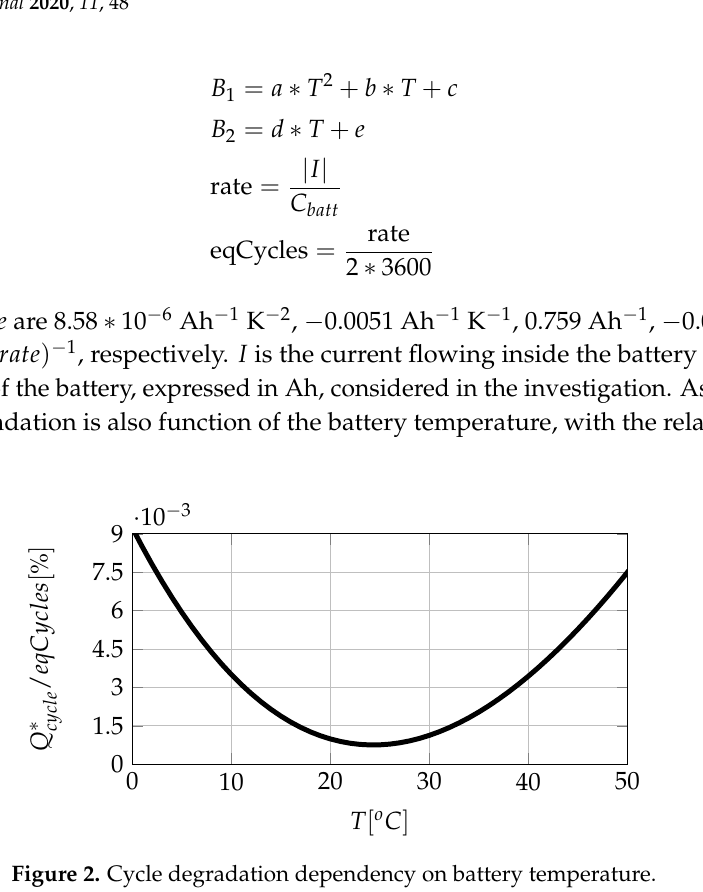
Figure 2. Cycle degradation dependency on battery temperature.